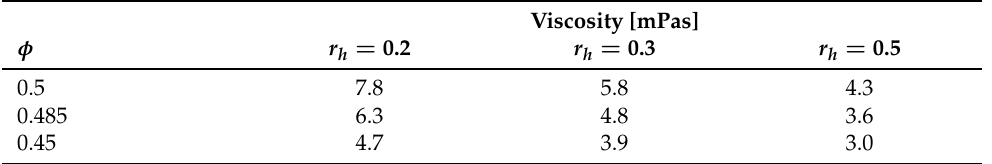
Table 6. Decrease in effective viscosity of particle suspension η in with respect to the decreasing